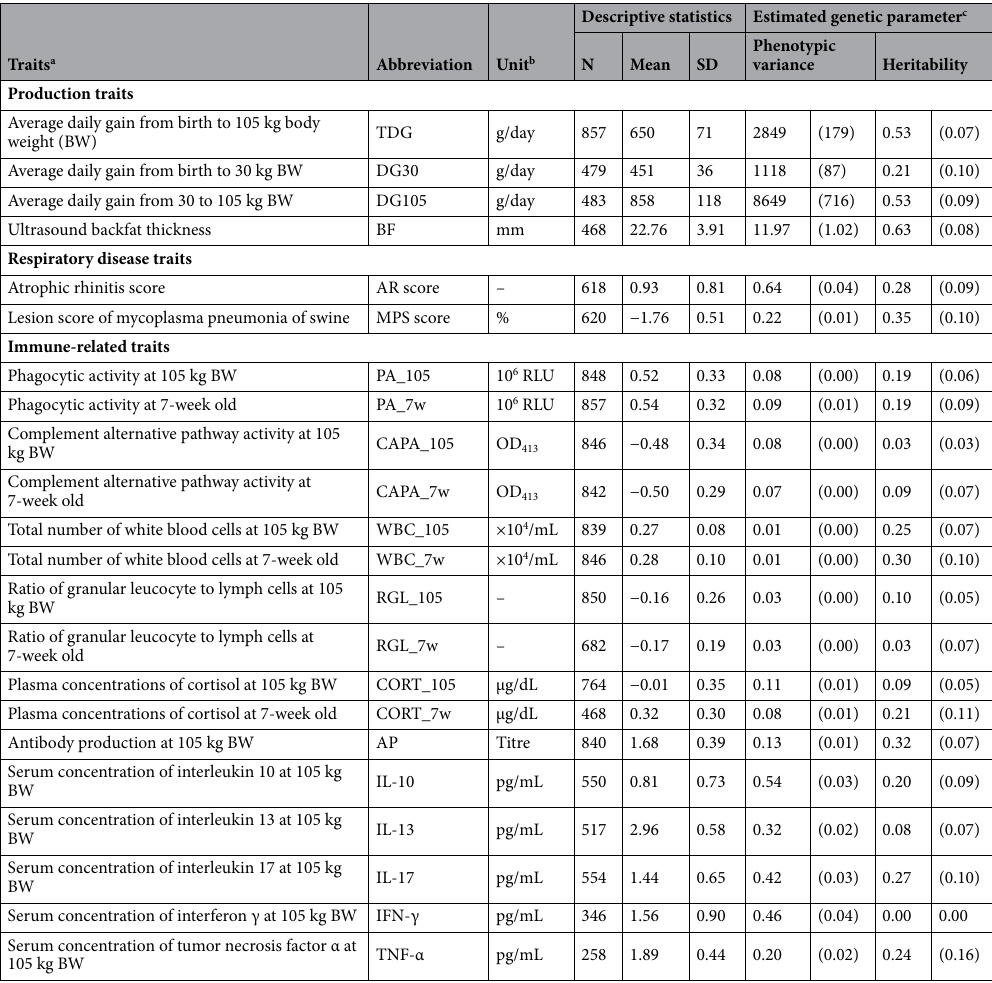
Table 2. Descriptive statistics and estimated genetic parameter of the study subjects. a MPS and immune- related traits were transformed to the natural logarithmic scale and the descriptive statistics of the transformed values are shown. b Titer unit is equivalent to 104/dilution degrees of sample serum. c Standard errors are shown in